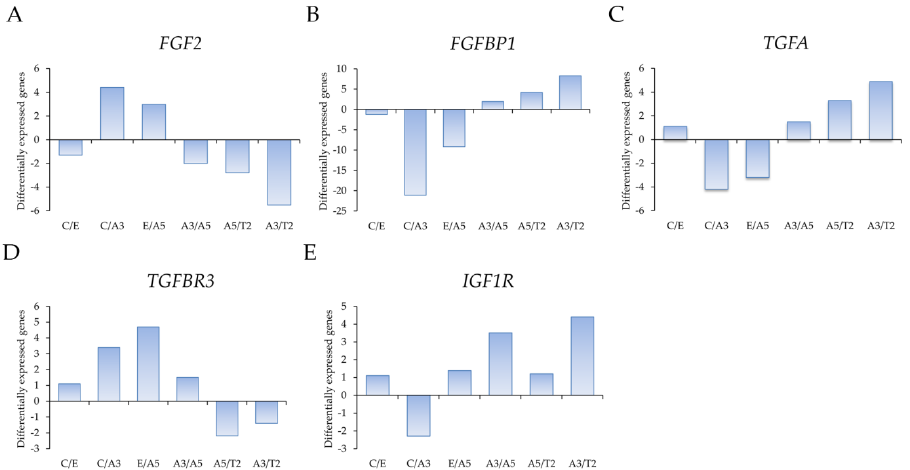
Figure 1. ( A ) Profiling of differentially expressed genes obtained through an Affymetrix array (U133A) data comparing ( A ) FGF2, ( B ) FGFBP1 , ( C ) TGFA , ( D ) TGFBR3 , and ( E ) IGF1R in the following cell lines: MCF-10F/Estrogen (C/E), Control/Alpha3 (C/A3), Estrogen/Alpha5 (E/A5), Alpha3/Alpha5 (A3/A5), Alpha5/Tumor2 (A5/T2), and Alpha3/Tumor2 (A3/T2). The graph was obtained from a cluster-dendrogram repository of gene expression from our laboratory for this article. The results indicated that high LET radiation such as that emitted by radon proge-